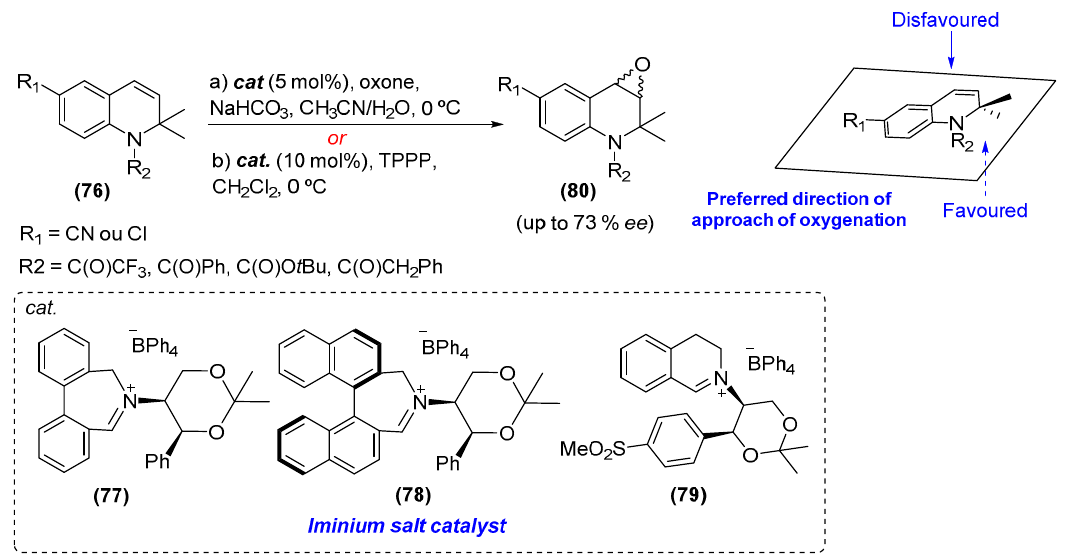
Scheme 17. Asymmetric epoxidation of dihydroquinoline using iminium